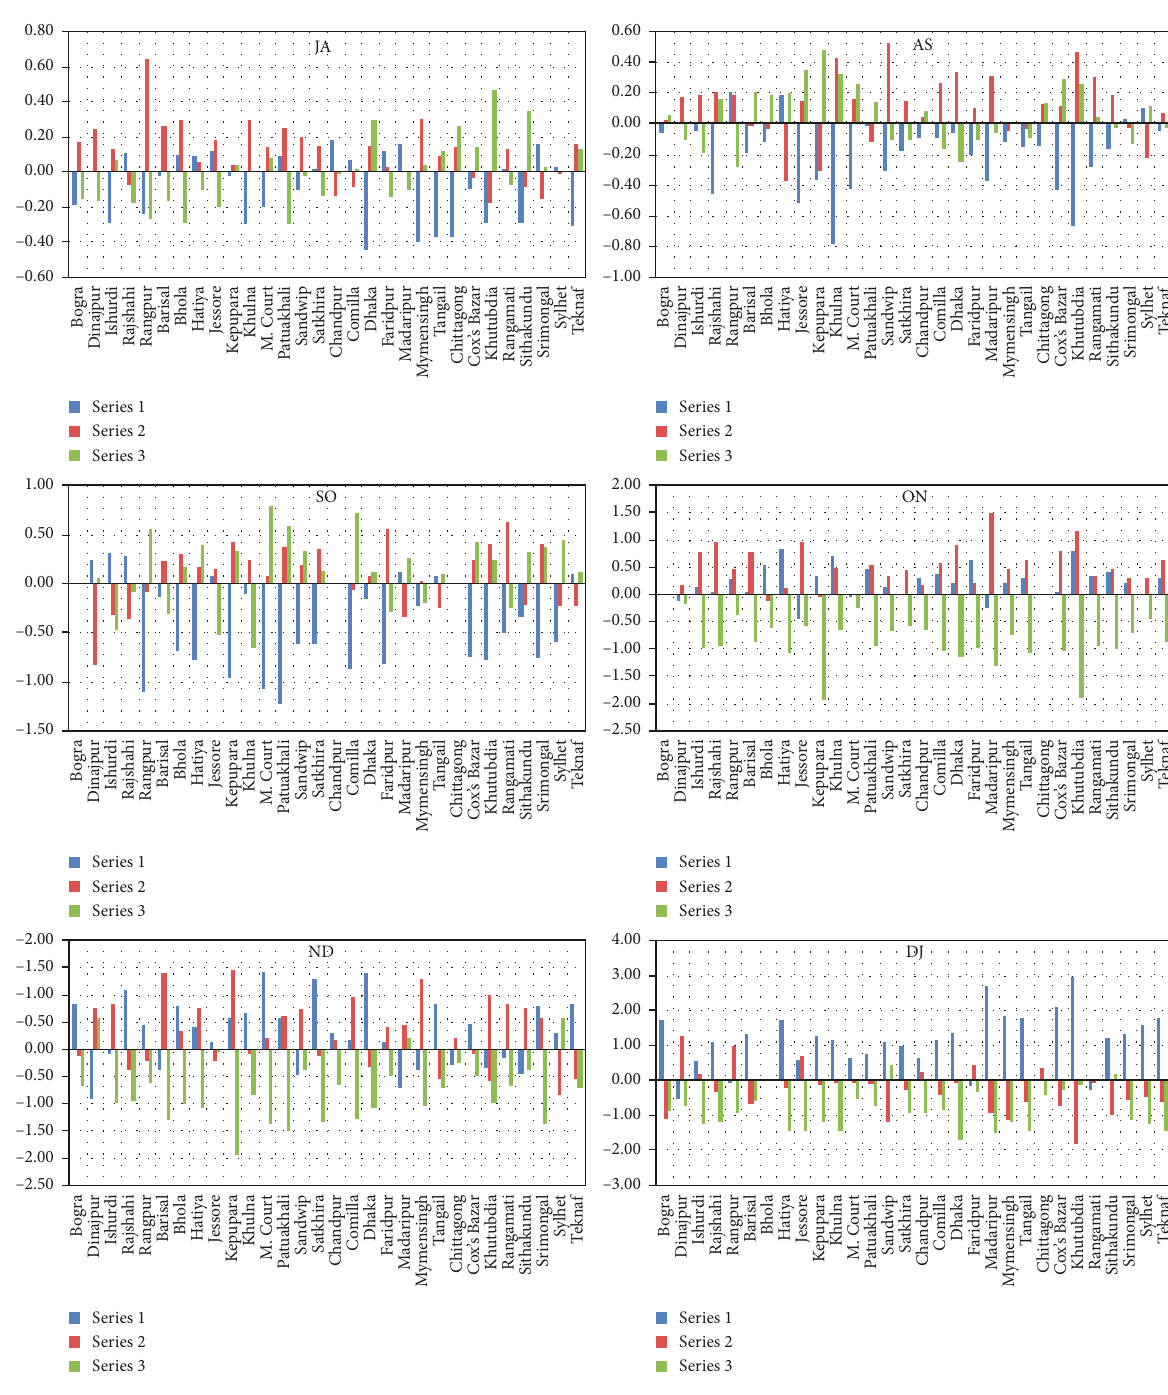
Figure 9: Two-month PCI changes in different periods from long-term mean PCI (1980–2011) (series 1 and series 3 (cid:31)